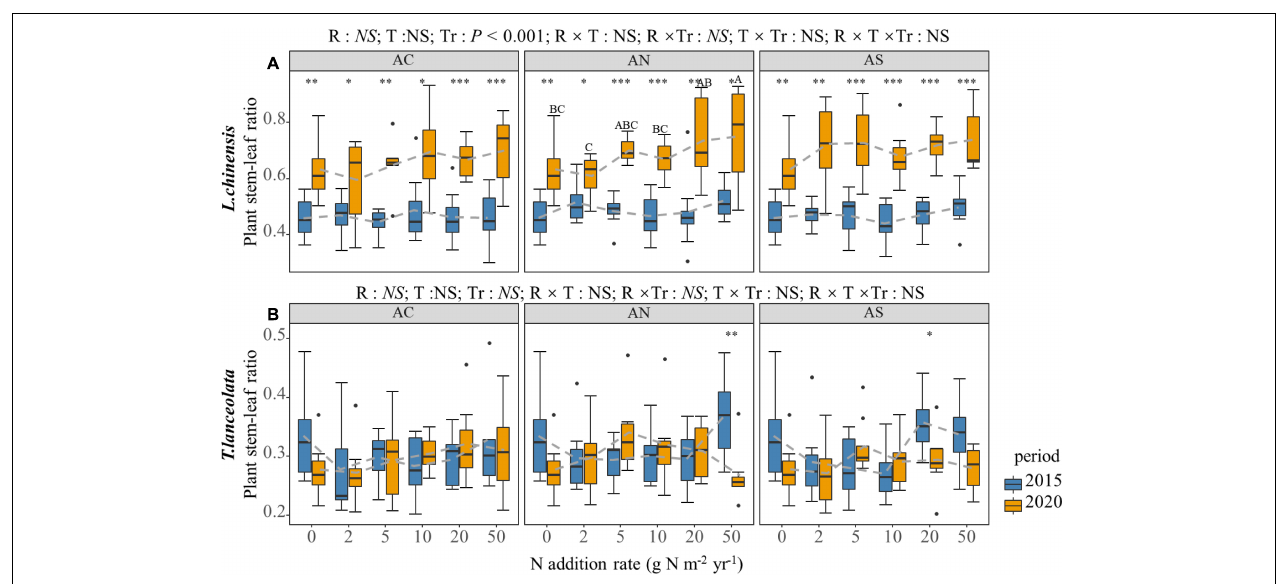
FIGURE 6 | Effects of short- and long-term nitrogen deposition on S:L of two species: (A) Leymus chinensis ; (B) Thermopsis lanceolata . The three-way ANOVA was used to test the effects of Pr, T and R on S:L. The effects of the nitrogen compound type alone and with nitrogen addition rate and year on S:L are not significant (NS, P > 0.05), thus one-way ANOVA (Tukey’s HSD) and t -tests are used to test the effects of nitrogen addition rate and year on S:L. Different lower-case and upper-case letters indicate significant differences ( P < 0.05) in LN among nitrogen addition rate in the 2015 and 2020 plots, respectively. The asterisk above the picture indicates the significant difference between the two years under each nitrogen addition rate. Note: ∗ P < 0.05; ∗∗ P < 0.01; ∗∗∗ P < 0.001. CK: non-fertilizer control = 0, N1 = 2, N2 = 5, N3 = 10, N4 = 20, and N5 = 50 kg N ha − 1 yr − 1 ; AC (NH 4 HCO 3 ), AN (NH 4 NO 3 ), AS [(NH 4 ) 2 SO 4 ]. The gray dashed line is the connection of the mean